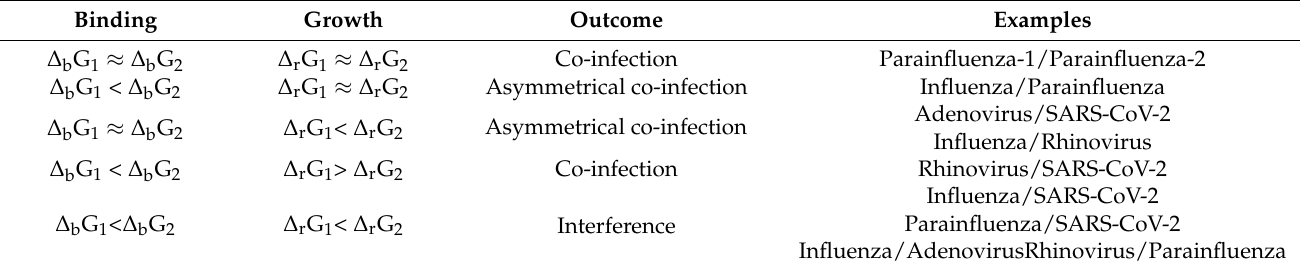
Table 5. Gibbs energies and outcomes of pathogen–pathogen–host interactions. “Asymmetrical co-infection” is a situation where two viruses are simultaneously present in a multicellular host, but one virus is more numerous. ∆ b G 1 and ∆ b G 2 are Gibbs energies of binding of two competing viruses, while ∆ r G 1 and ∆ r G 2 are their Gibbs energies of growth. Binding Growth Outcome